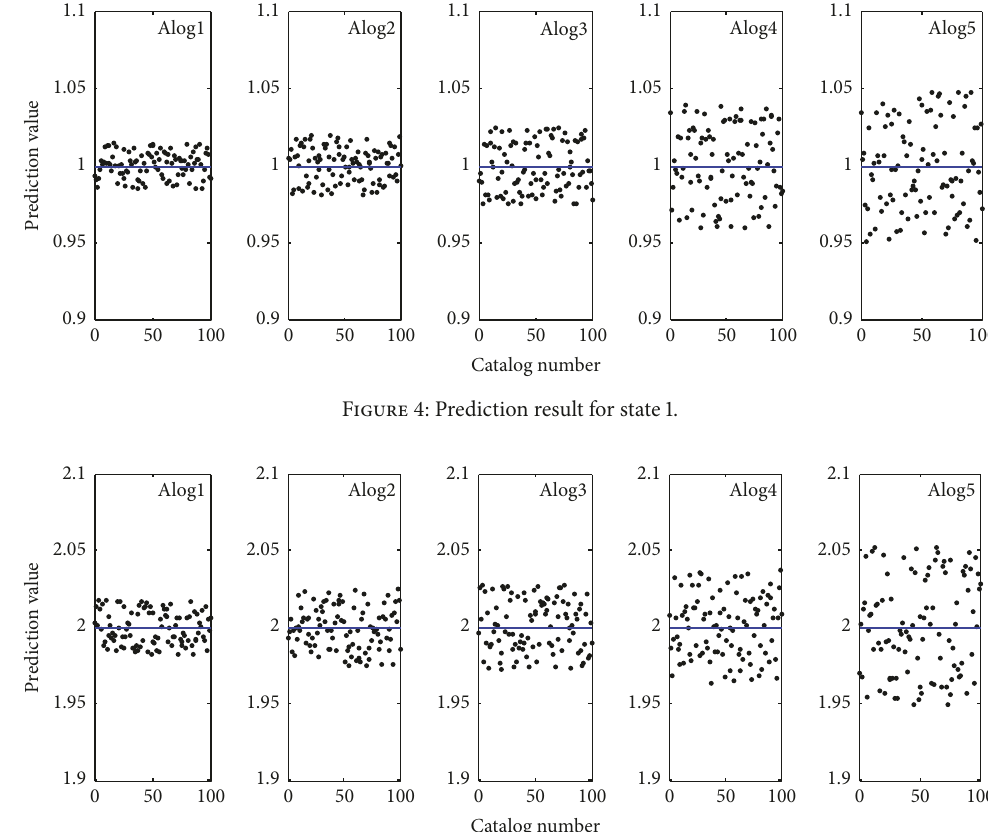
Figure 5: Prediction result for state 2.